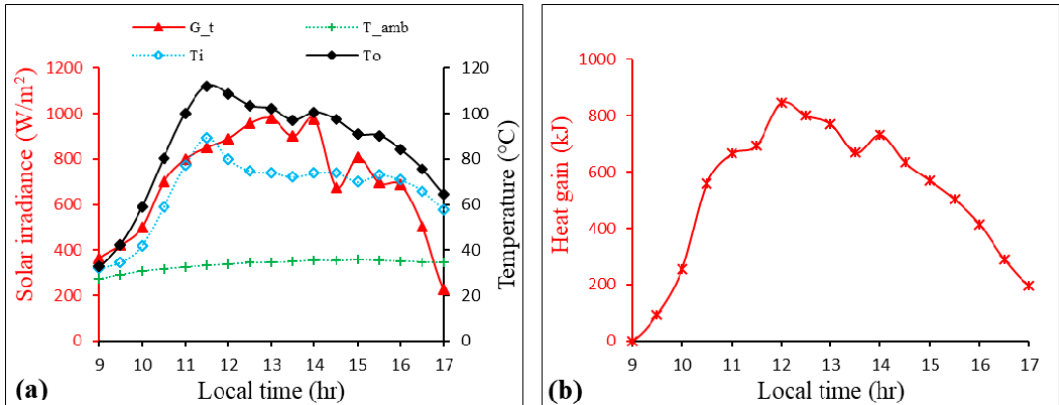
Figure 15. Experimental results of CPC collector with CT receiver: ( a ) solar irradiance and temperatures and ( b ) heat gain for N-S installation recorded on 26 th Apr 2019.